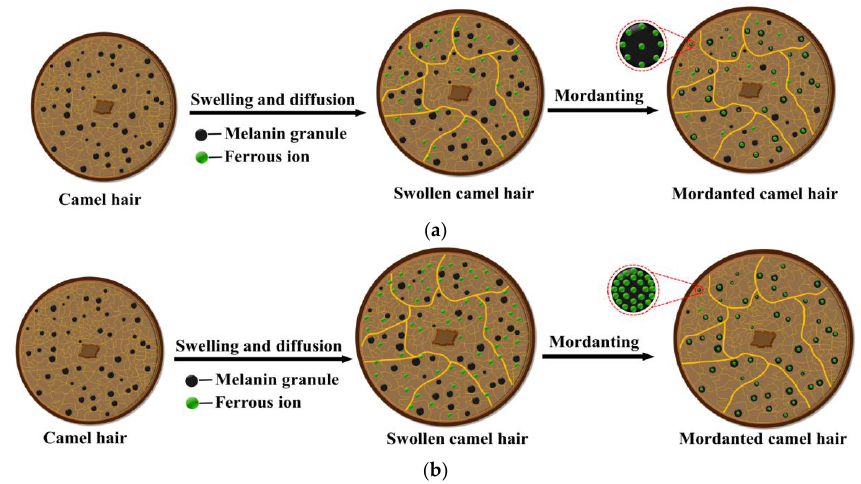
Figure 13. Principle of mordanting in ( a ) the water system and ( b ) the ethanol–water system.